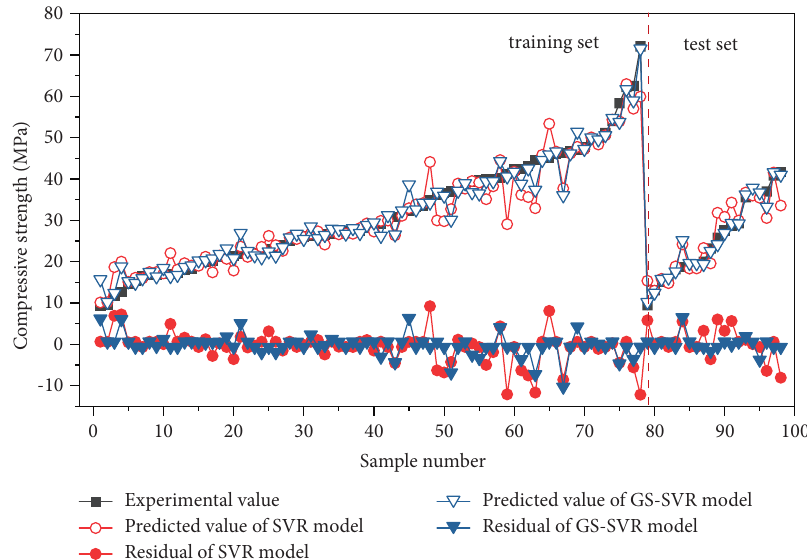
Figure 7: Comparison of predicted and actual values for two models.